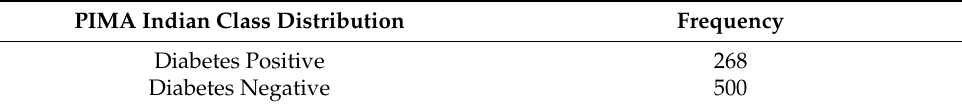
Table 3. Class distribution in the